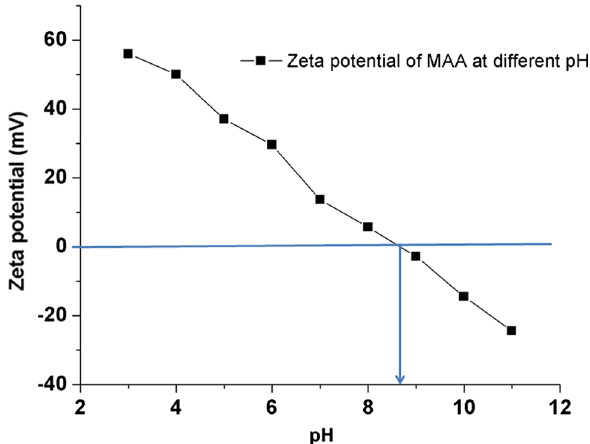
Fig. 5 Zeta potential of MAA at different solution pH